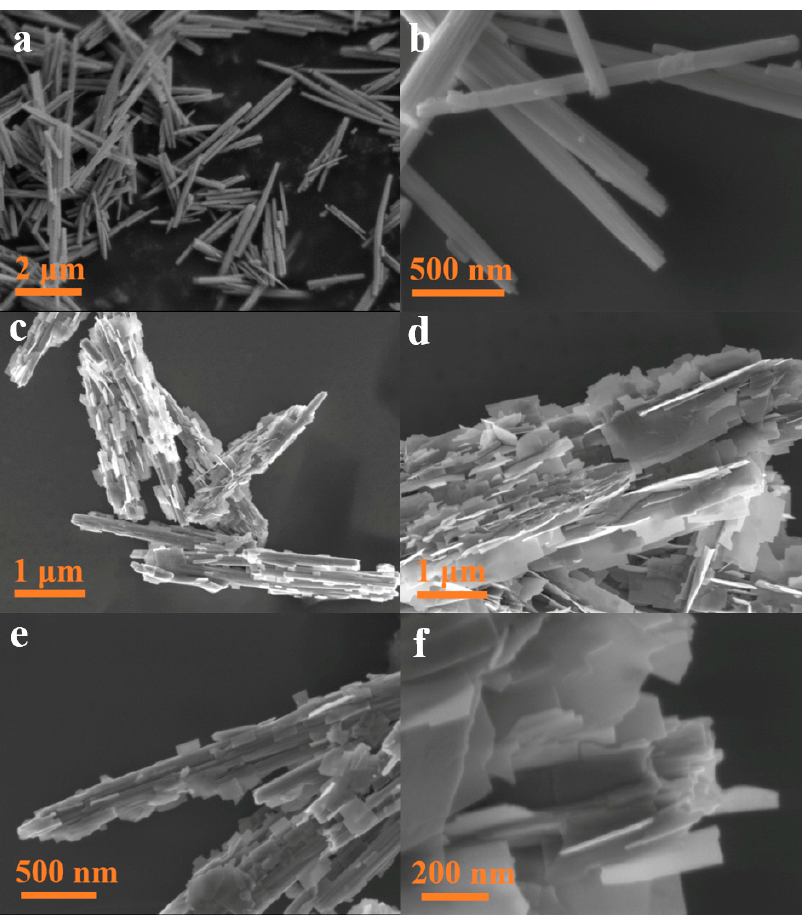
Figure 4. The SEM images of WO 3 ( a , b ) and BW3 ( c – f ).